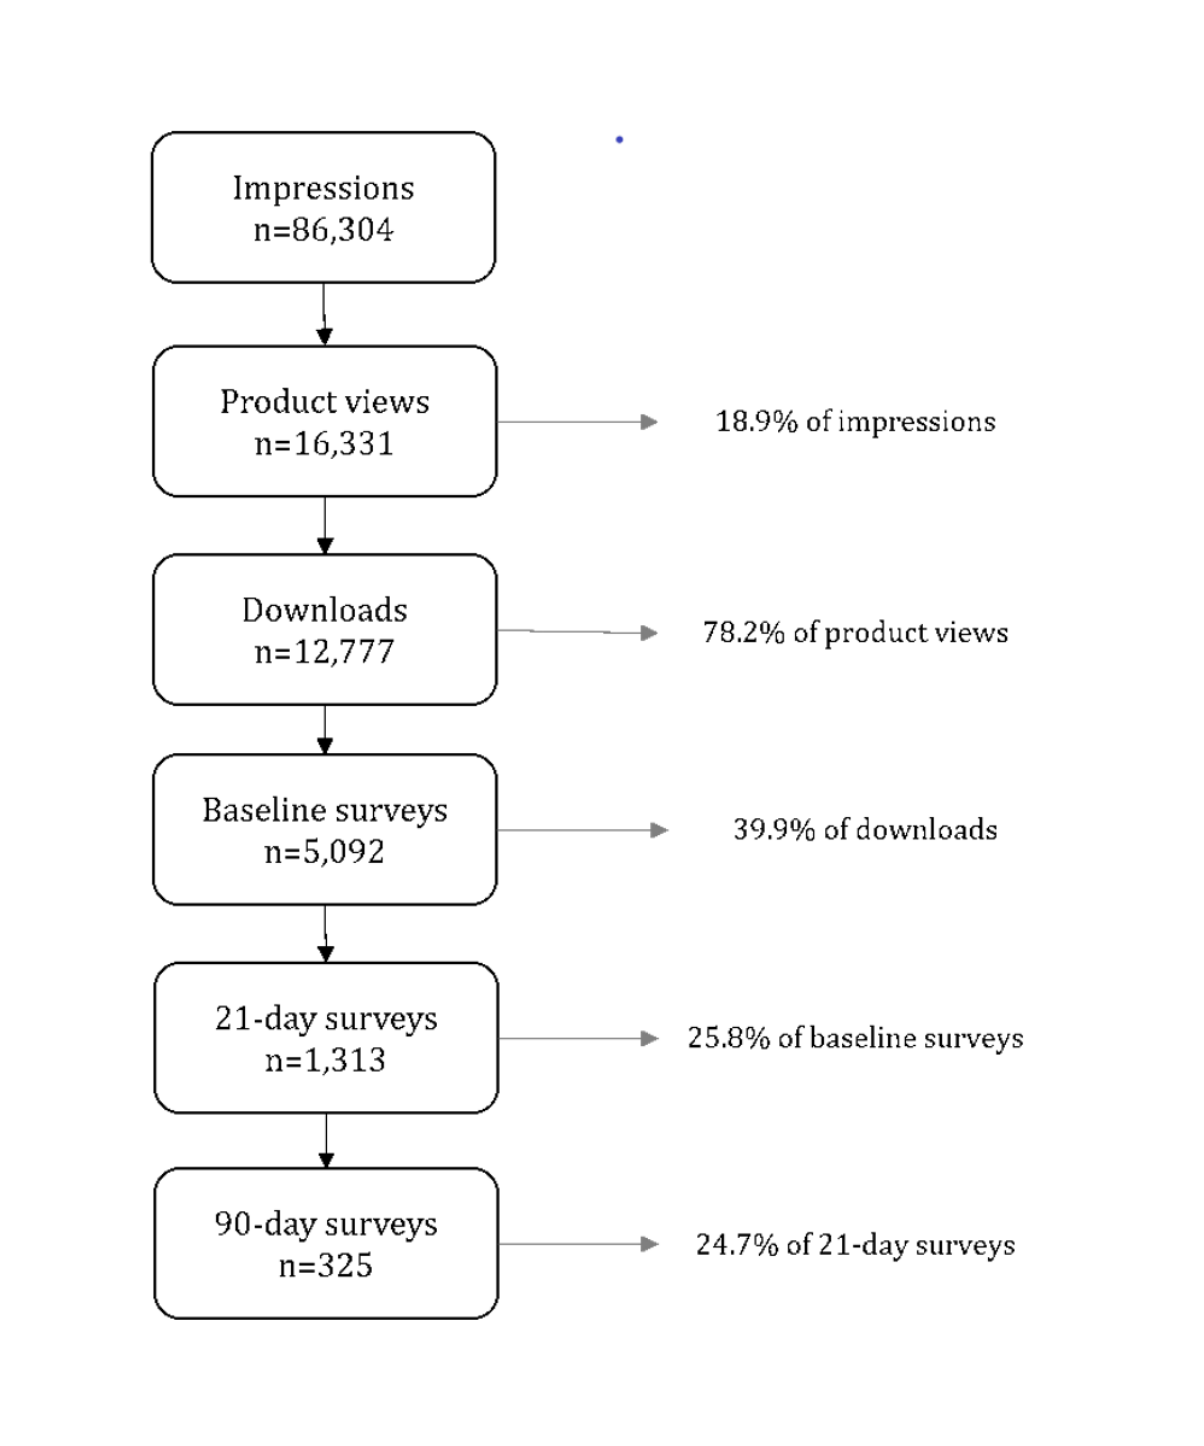
Figure 3. A flow chart of participants in the VegEze